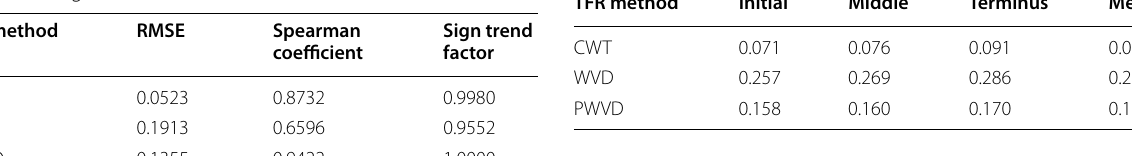
Table 3 RUL prediction performance of bearing 1-3 based on different TFR generation methods